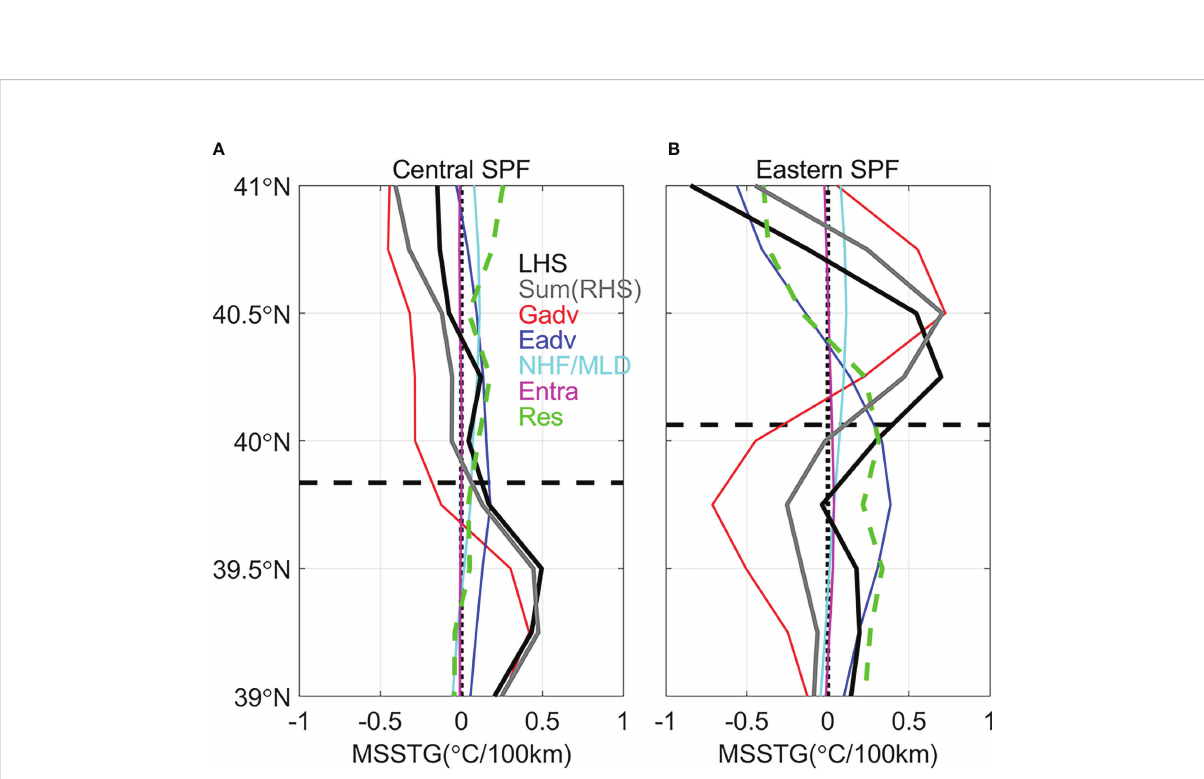
FIGURE 5 Zonal averaged decadal change in the MSSTG between 1993 – 2002 and 2011 – 2020 (the latter minus the former; unit: °C/100km) calculated by the frontogenesis rate equation for (A) 130 – 135°E (central SPF) and (B) 135 – 138°E (eastern SPF). Black horizontal dashed lines represent main axis position of the SPF. Black vertical dashed lines represent 0 value. Black thick solid lines indicate the results of the frontogenesis rate term [the LHS of equation (3)]. Red, blue, cyan and magenta solid lines represent the geostrophic advection (Gadv), Ekman advection (Eadv), NHF/ MLD and entrainment (Entra) terms, respectively. Gray thick solid lines indicate the sum of the RHS of equation (3) (sum of Gadv, Eadv, MHF/ MLD and Entra). Green thick dashed lines (Res) represent differences between the LHS and RHS of equation (3).